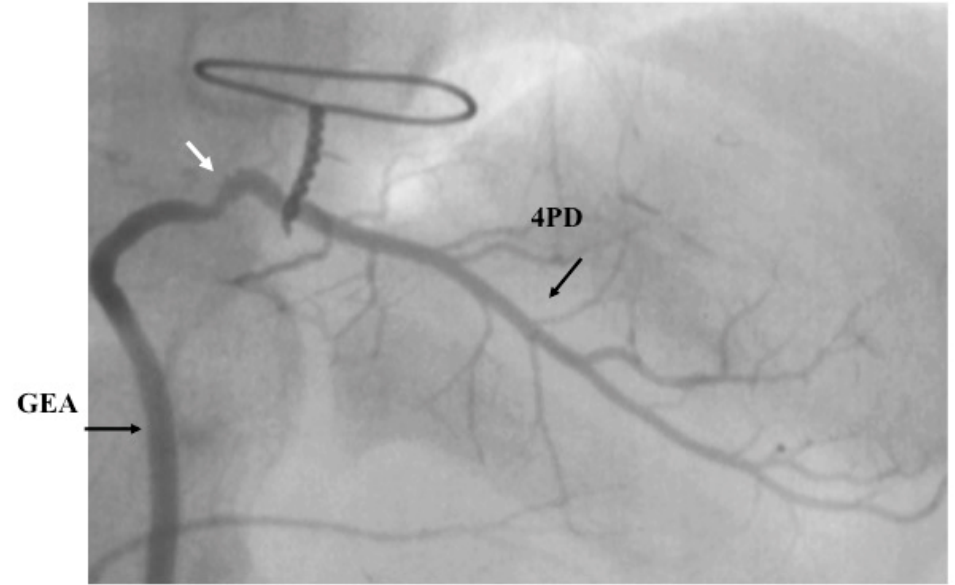
Figure 4. Gastroepiploic-artery (GEA) graft 11 months after surgery. A six-year-old boy had grafting of the posterior descending branch of the right coronary artery with GEA.